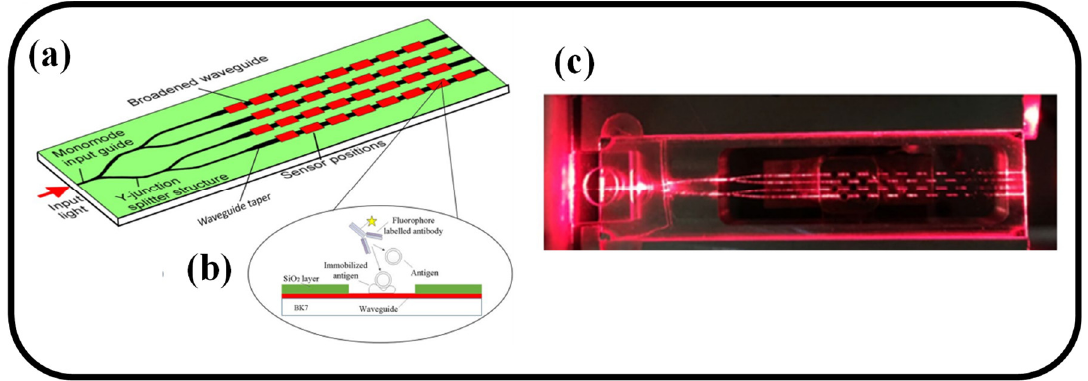
Figure 6. Integrated chip ( a ) an illustration of the sensor arrangement [122], ( b ) an illustration of one of the sensing patches in cross-section, highlighting the isolation layer, waveguide, and placement of the surface chemistry [122], ( c ) a visual representation of light movement along the waveguide chip [122].